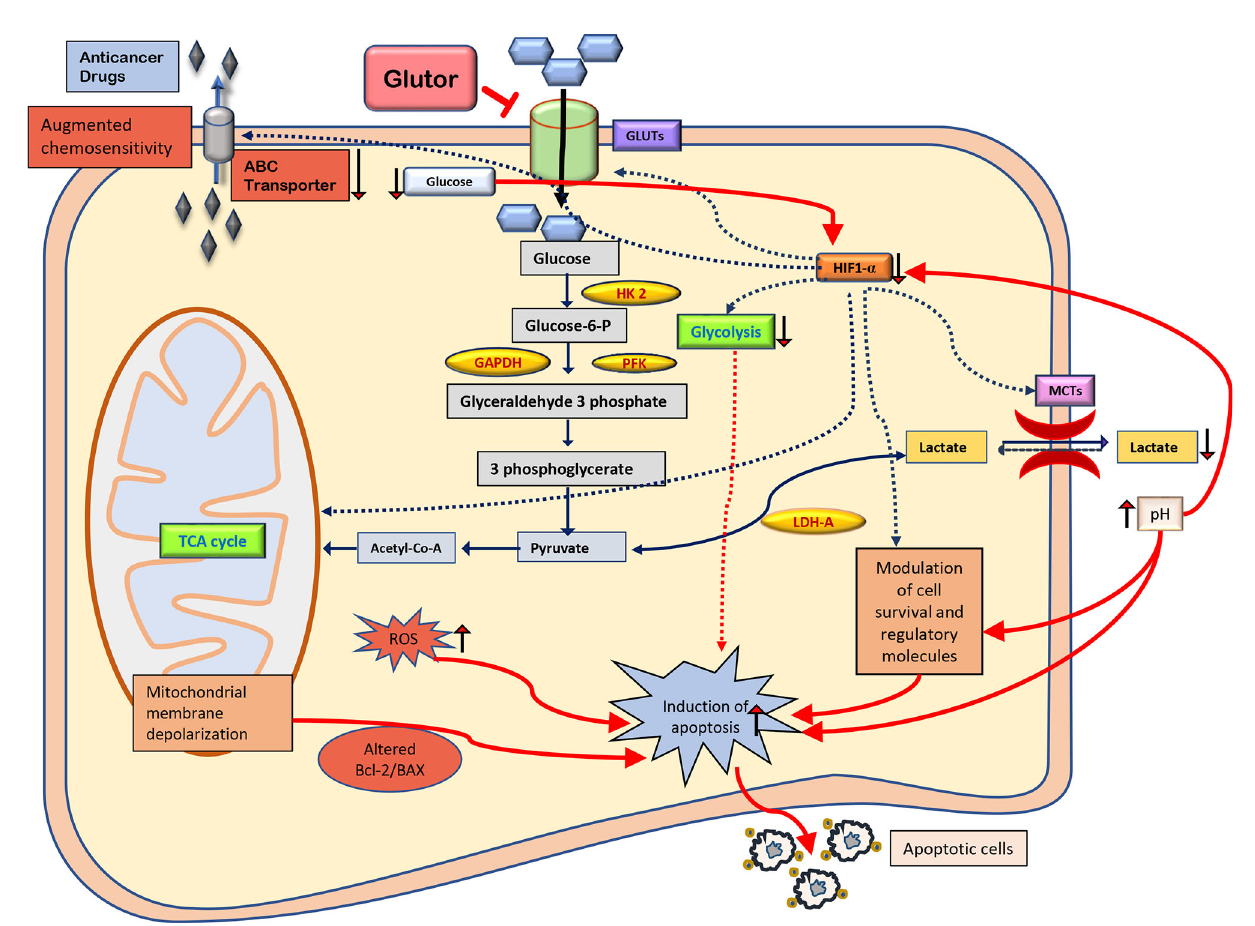
FIGURE 9 | Summary of the molecular mechanisms of the antineoplastic and chemosensitizing action of glutor. The antineoplastic action of glutor involves diminished uptake of glucose, modulated expression of metabolic and cell survival regulatory molecules, altered pH homeostasis, intracellular ROS production, and chemosensitivity. Abbreviations: GLUT, glucose transporter; HK 2, hexokinase 2; GAPDH, glyceraldehyde 3-phosphate dehydrogenase; PFK, phosphofructokinase; HIF-1 a , hypoxia-inducible factor 1-alpha; LDH-A, lactate dehydrogenase A; MCTs, monocarboxylate transporters; Bcl-2, B-cell lymphoma 2; BAX, Bcl-2 Associated X; ROS, reactive oxygen species; ABC transporter, ATP-binding cassette